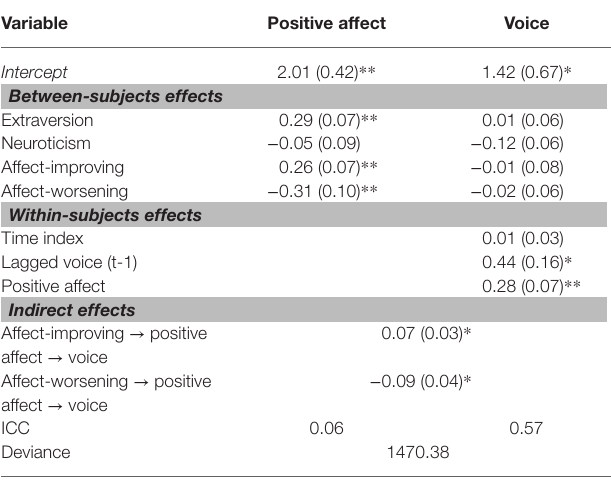
TABLE 2 | Multilevel structural equation modeling (MSEM) for voice, positive affect, and emotion regulation.